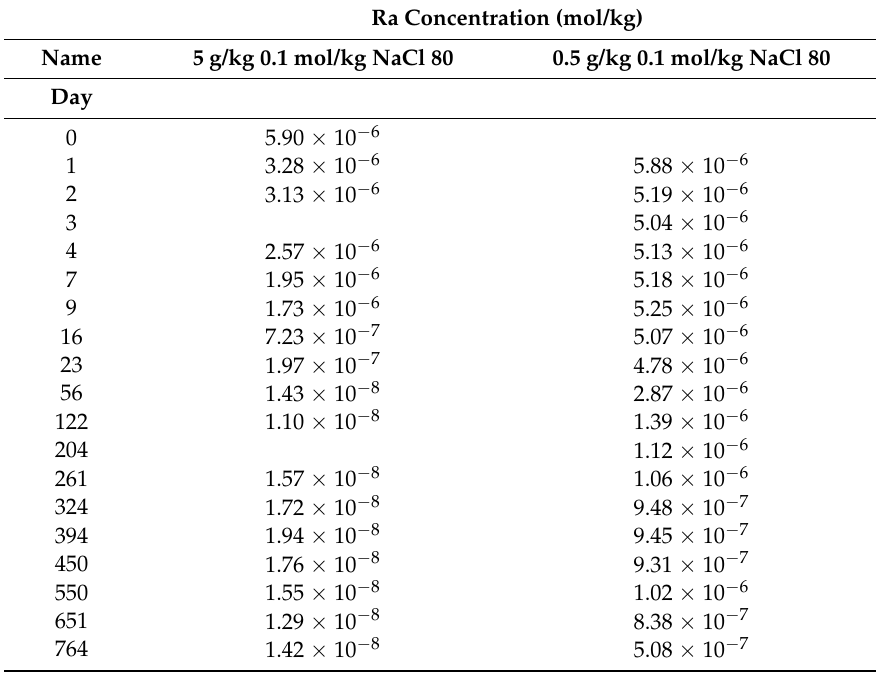
Table A3. Ra concentrations of experiments with 0.1 mol/kg NaCl at 80 ◦